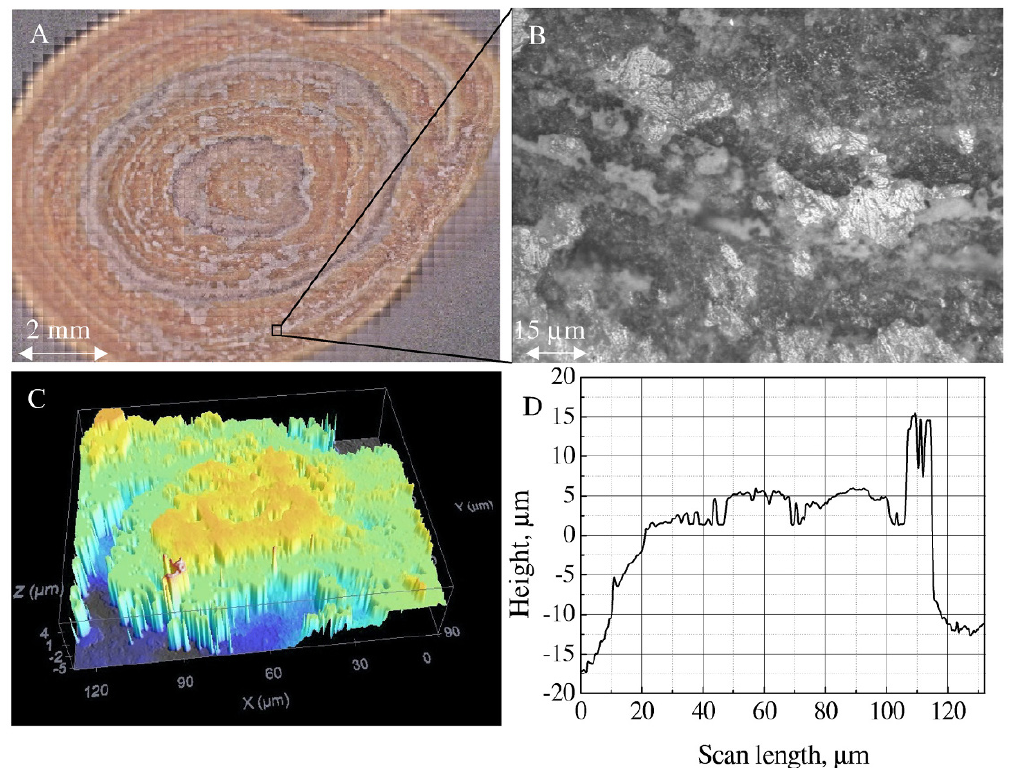
Figure 2. Cross-sectioned uric acid - calcium oxalate urinary stone surface : A – optical image obtained by mapping; B – optical image of the profiled area; C – 3-D topology of the area; D - one-dimensional profile of a diagonal